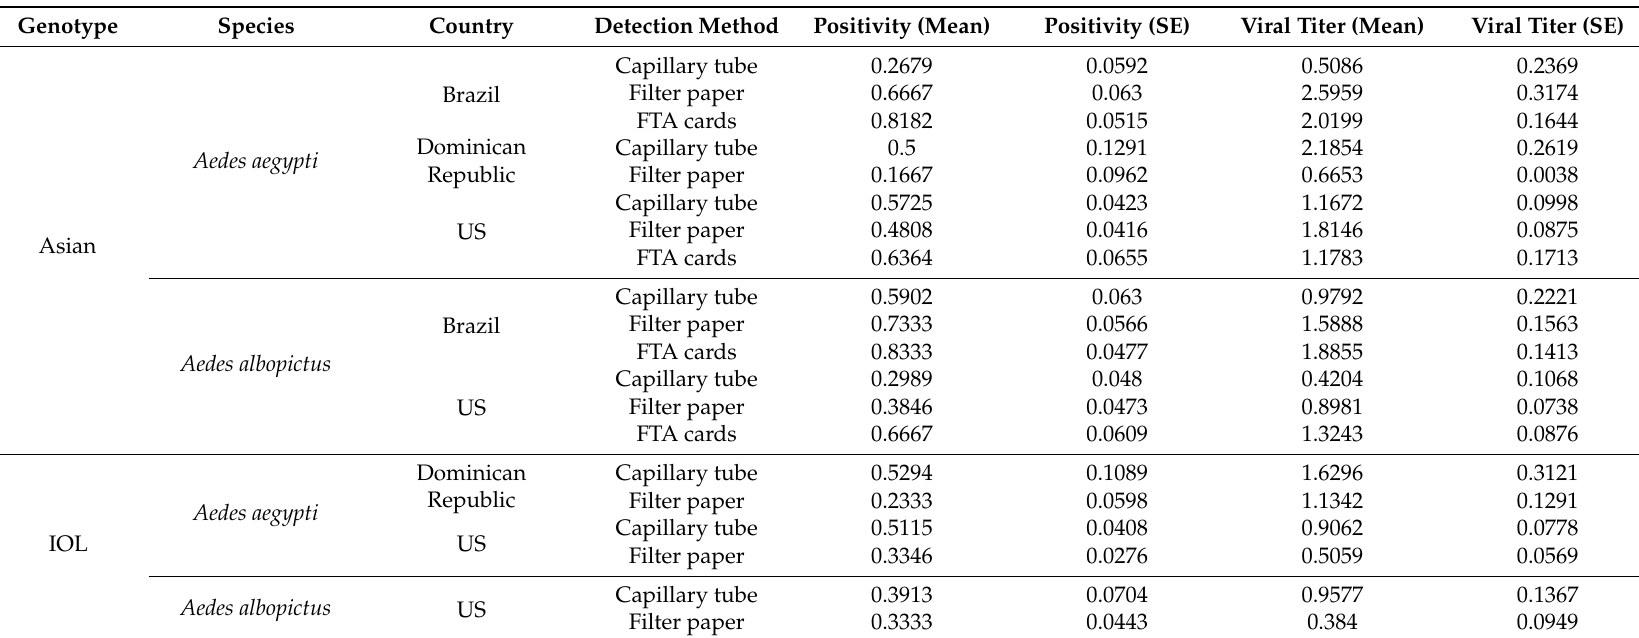
Table 1. Descriptive statistics of the proportion of positive saliva infection (mean and SE) and viral titer (log 10 pfue / mL, mean, and SE) for two CHIKV genotypes (Asian and IOL) for Ae. aegypti and Ae. albopictus from three di ff erent countries (Brazil, Dominican Republic, and the US) and using three collection methods (capillary tube, filter paper, and FTA